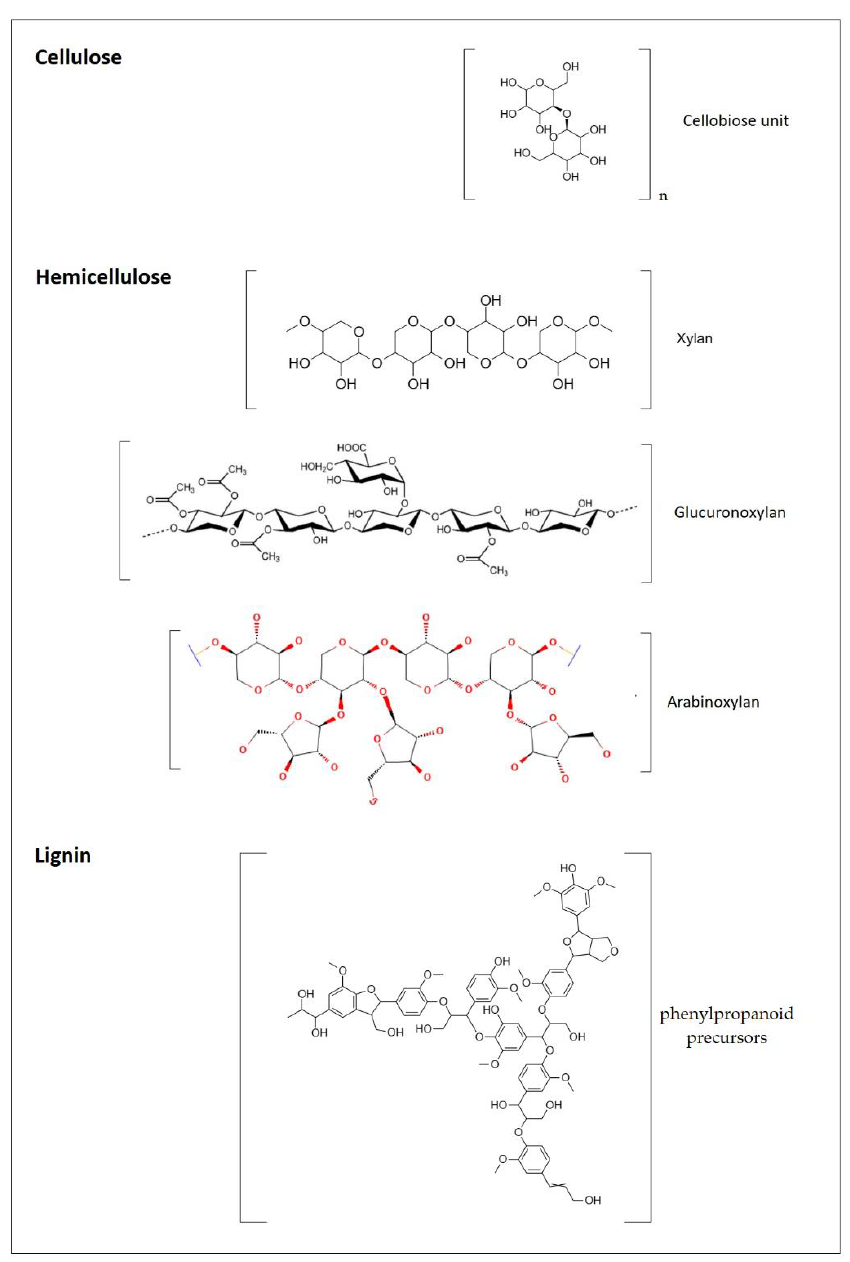
Figure 1. Structure of biomass.